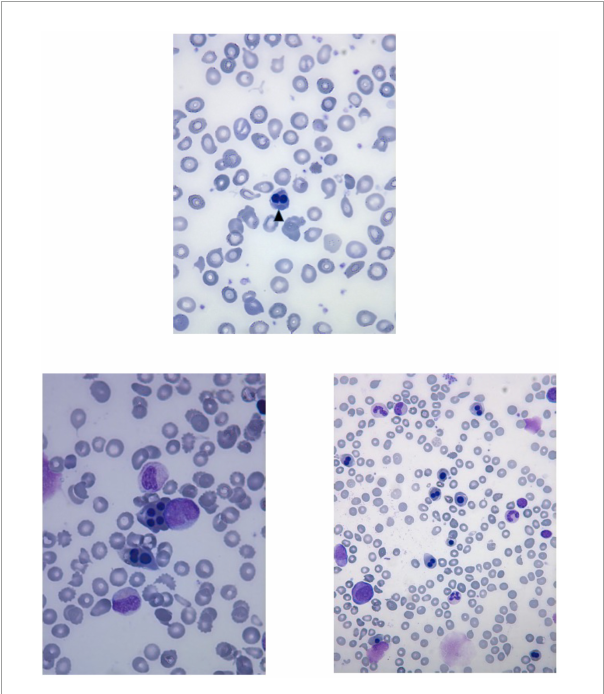
FIGURE3 Peripheral blood smear of the patient six shows anisocytosis, poikilocytosis, fragmentocytes and binucleated normoblast (arrowhead). Bone marrow aspirates of the patient six show multinucleated erythroid precursors and dyserythropoiesis.